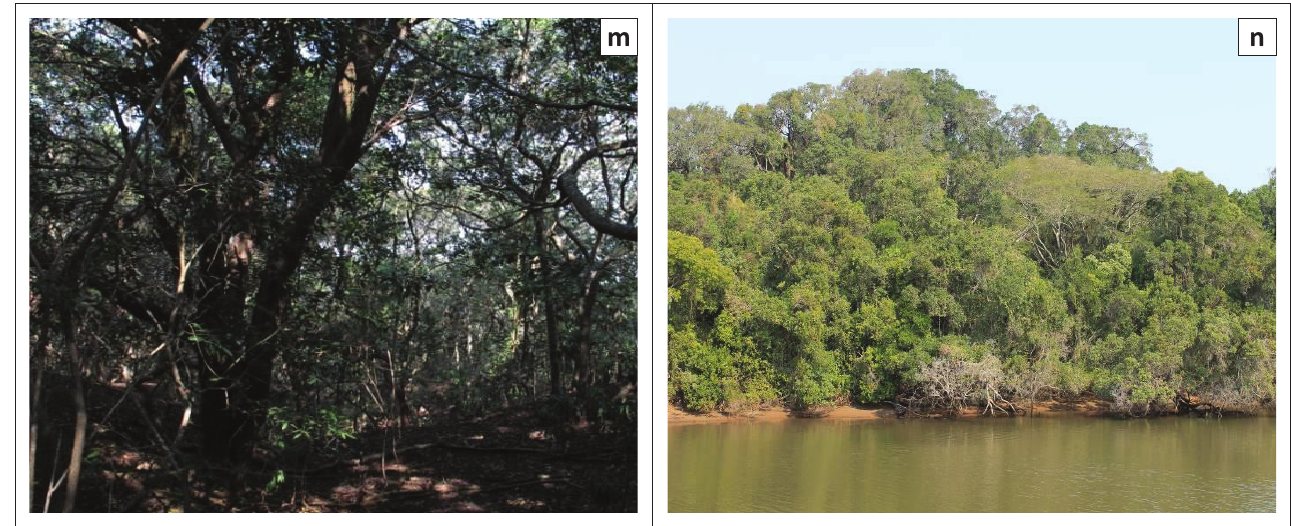
FIGURE 3 (Continues ...): Representative photographs of the uMlalazi Nature Reserve plant communities: (a) Salicornia meyeriana–Avicennia marina salt marsh community, (b) Bruguiera gymnorrhiza–Avicennia marina mangrove forest, (c) Phragmites australis–Juncus kraussii saline wetland, (d) Scaevola plumieri–Gazania rigens foredune community, (e) Typha capensis–Cyperus dives wetland community, (f) Digitaria eriantha–Dactyloctenium australe secondary coastal grasslands, (g) Stenotaphrum secundatum–Phragmities australis freshwater wetland, (h) Passerina rigida–Carpobrotus dimidiatus dune scrub community, (i) Adenopodia spicata–Vachellia robusta riverine woodland community, (j) Albizia adianthifolia–Chromolaena odorata disturbed coastal dune forest, (k) Tricalysia sonderiana–Apodytes dimidiata dune forest margin, (l) Gymnosporia arenicola–Protorhus longifolia coastal dune forest, (m and n) Carissa bispinosa–Mimusops caffra climax coastal dune forest.